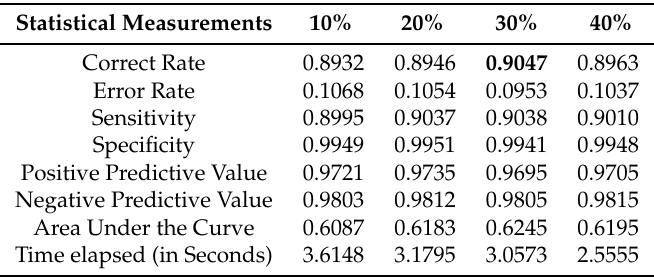
Table 3. Classification result of the proposed